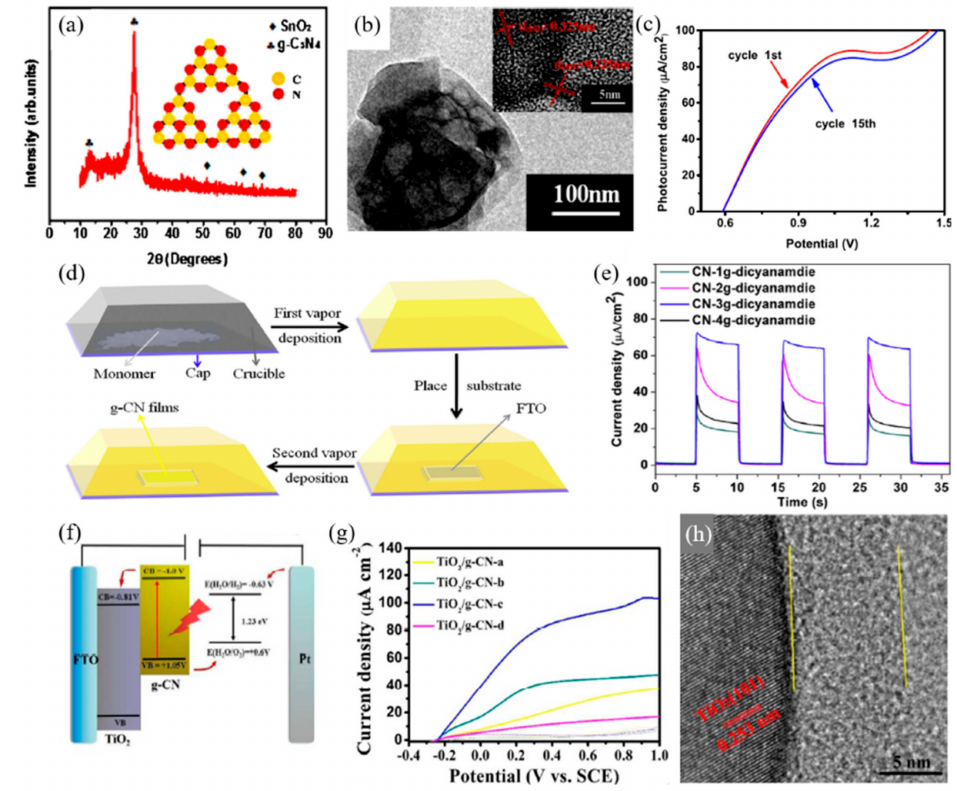
Figure 5. Graphitic carbon nitride (g-C 3 N 4 ) applied in photoelectrochemical cells for water splitting reactions. ( a ) XRD of the framework g-C 3 N 4 film on FTO, inset shows the tri-s-triazine units of g-C 3 N 4 , ( b ) TEM image of the framework g-C 3 N 4 , inset shows the HRTEM image, ( c ) Linear sweep voltammograms (LSV) curve of the framework g-C 3 N 4 film [65]. ( d ) Schematic diagram of the thermal vapor deposition (TVD) procedure for deposition of g-C 3 N 4 films on FTO. ( e ) Transient photocurrent density under light illumination of the g-C 3 N 4 films prepared using di ff erent amount of dicyanamide [23]. ( f ) Schematic diagram of PEC water oxidation mechanism on the TiO 2 / g-C 3 N 4 arrays under visible light, ( g ) Linear sweep voltammograms (LSV) of TiO 2 / g-C 3 N 4 Core-shell Arrays under illumination ( λ > 420 nm) and dark states. ( h ) HRTEM image of TiO 2 / g-C 3 N 4 composite